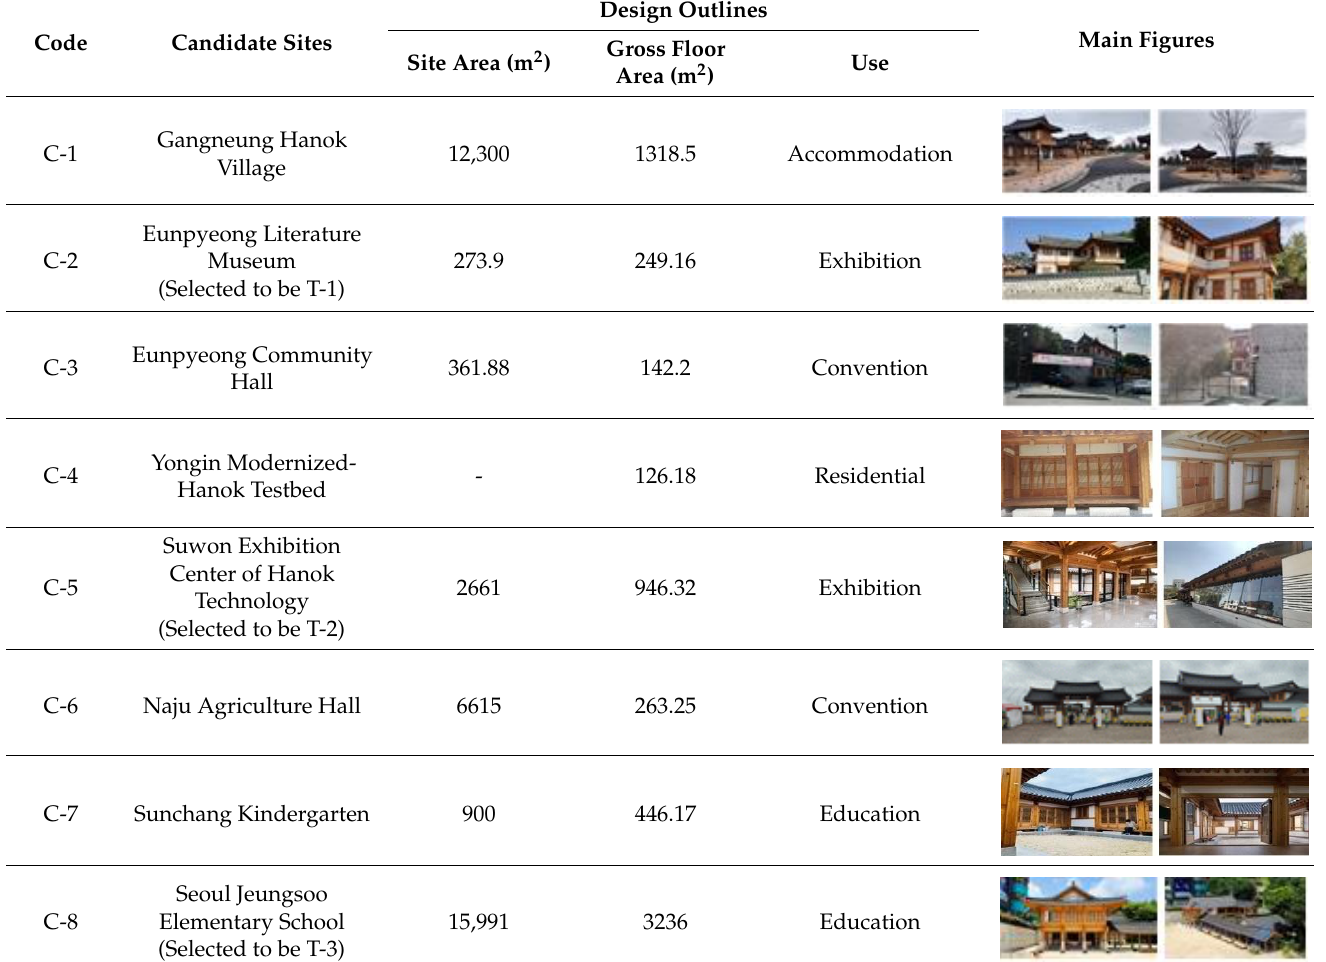
Table 2. Outlines of candidate target Hanoks.